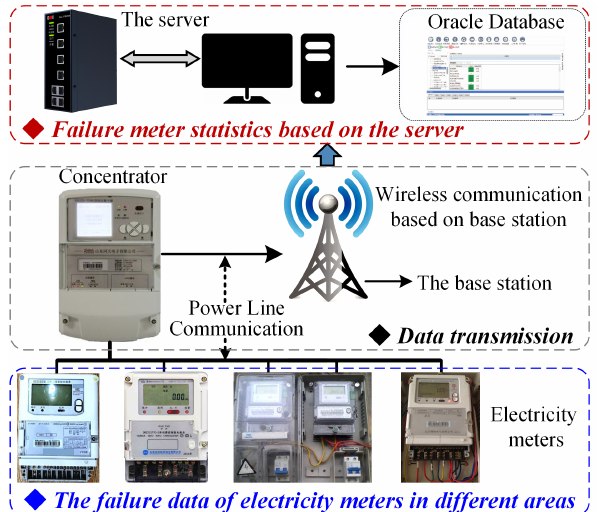
Figure 1. Operation status monitoring platform of the electrical meters.